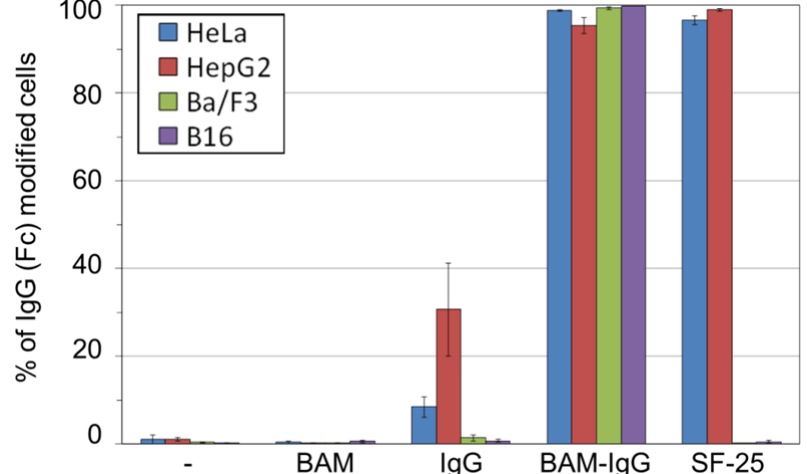
Figure 3. Fc-positive ratios of various cell lines analyzed by flow